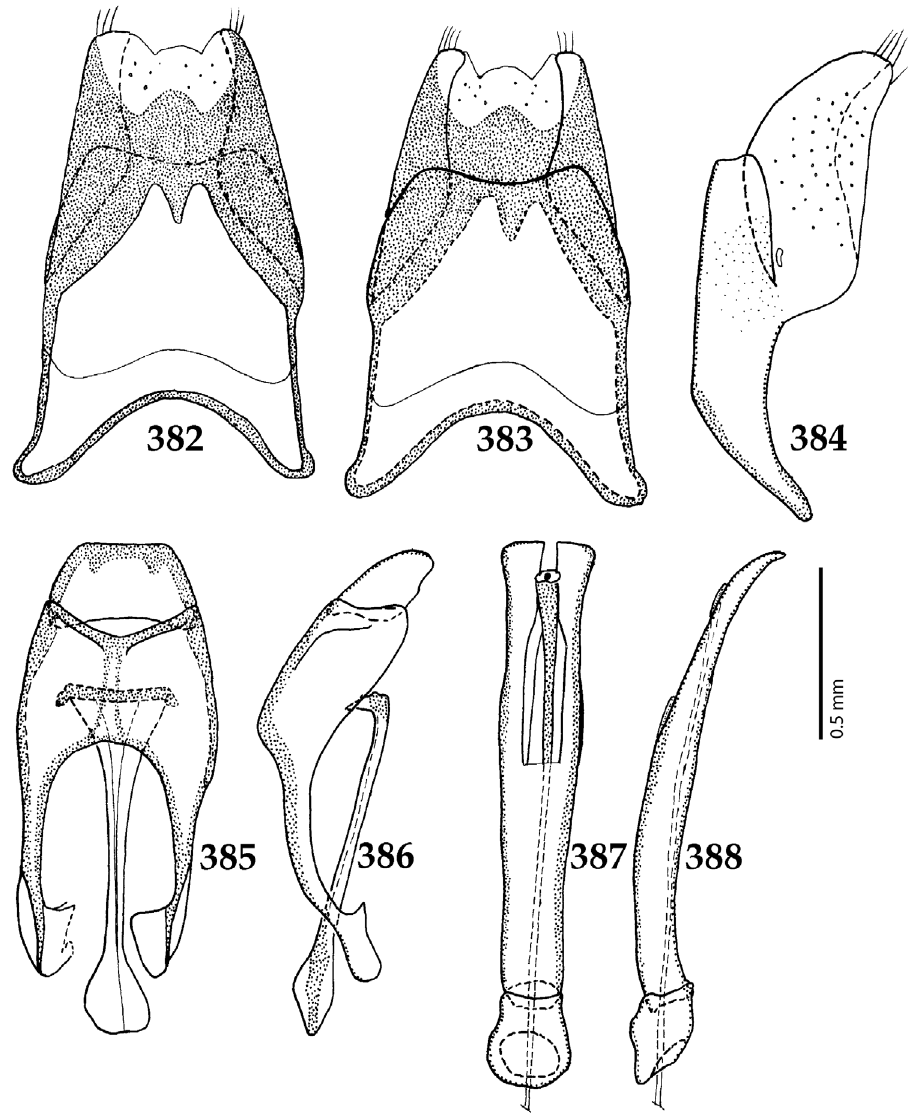
Figures 382–388. 382 Saprinus ( Saprinus ) chathamensis sp. n. male terminalia: 8 th sternite + 8 th tergite, ventral view 383 ditto, dorsal view 384 ditto, lateral view 385 male terminalia: 9 th + 10 th tergites, dorsal view; spiculum gastrale, ventral view 386 male terminalia: 9 th + 10 th tergites; spiculum gastrale, lateral view 387 male terminalia: aedeagus, dorsal view 388 ditto, lateral view.